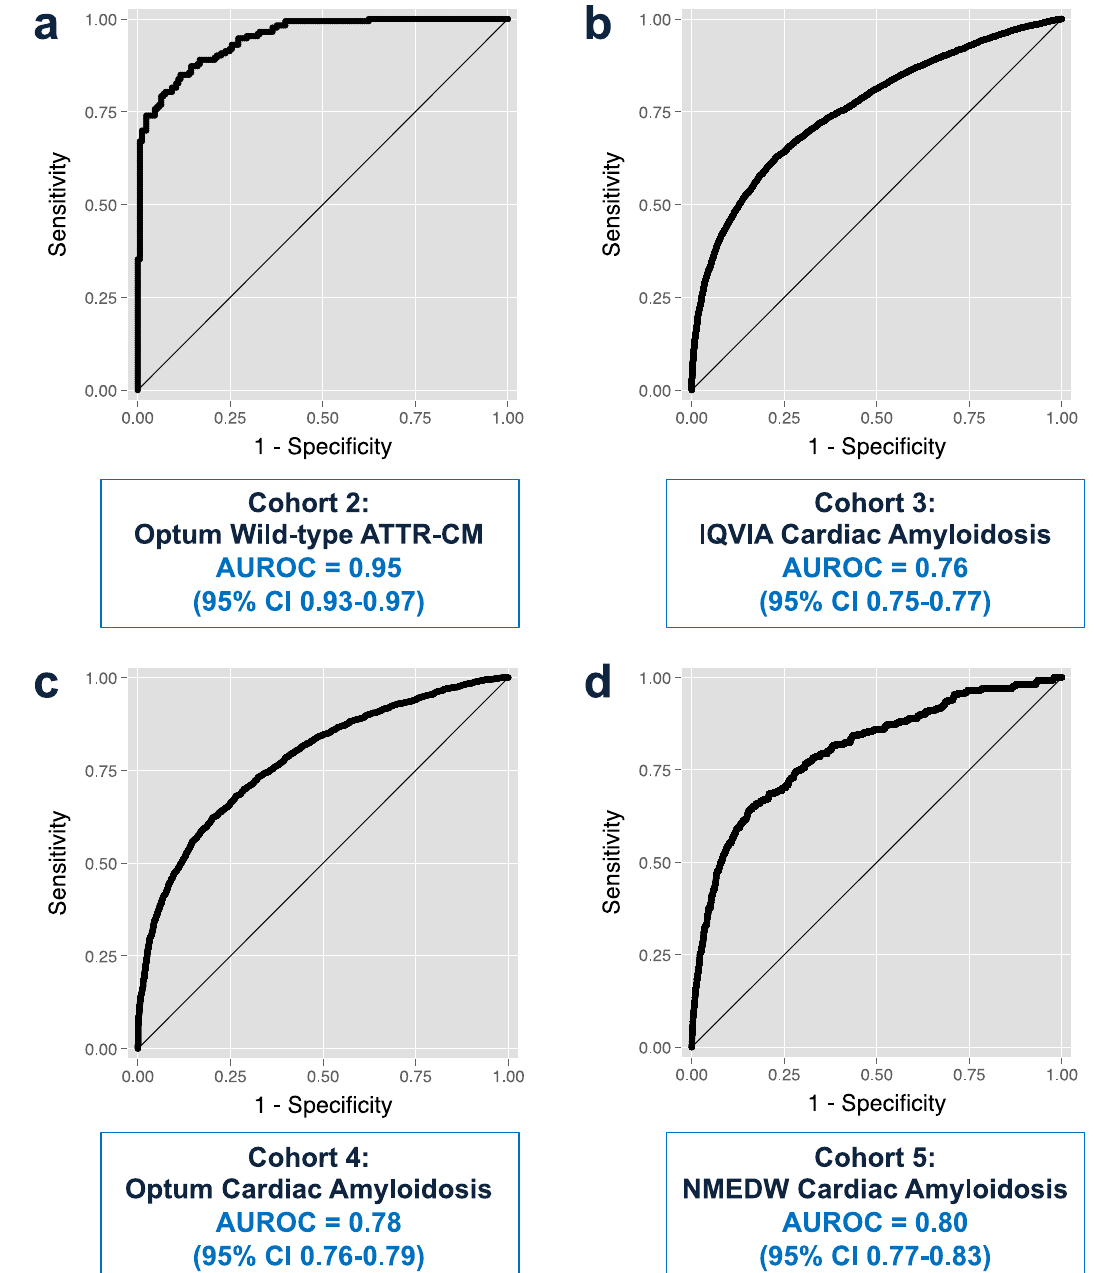
Fig. 1 Receiver operating characteristic curves for the Random Forest machine learning model in the four validation cohorts. a Optum ATTR-CM validation cohort. b IQIVA cardiac amyloidosis validation cohort. c Optum cardiac amyloidosis cohort. d Northwestern Medicine Enterprise Data Warehouse validation cohort. AUROC, area under the receiver operating characteristic curve; ATTR-CM, amyloidogenic transthyretin cardiomyopathy; NMEDW, Northwestern Medicine Enterprise Data